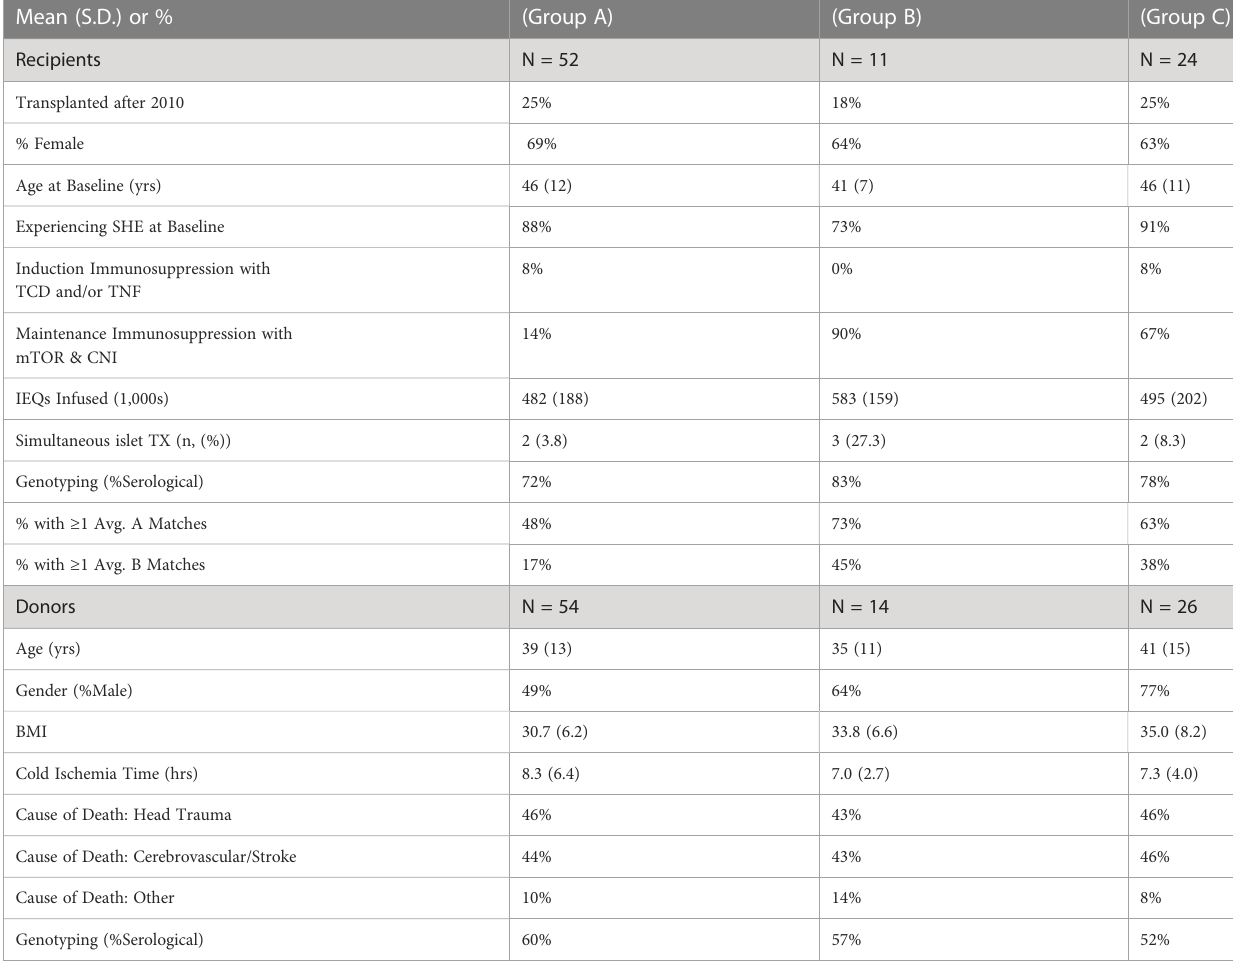
TABLE 2 Key baseline characteristics of islet transplant recipients and